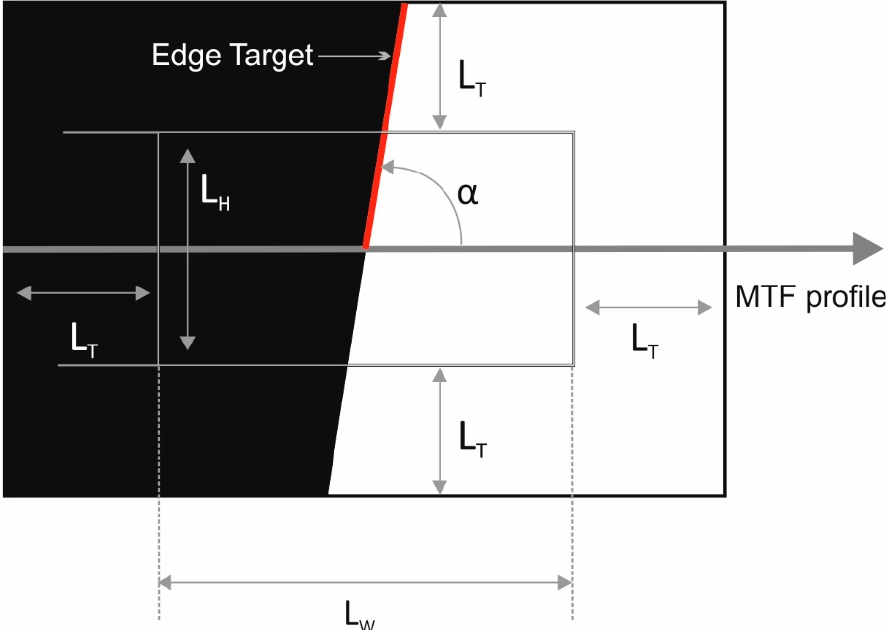
Figure 4. Schematic representation of the parameters for edge target selection (image courtesy [33]). The ESF calculation proposed by Kohm [34] uses the measurements for both orienta- tions (AL and AC). As an example, edge interpolation was performed for every line for the area shown with a red rectangle in Figure 3a. Afterwards, parametric functions were fitted in order to estimte the bottom of the inflection point, and least squares fitting was used to obtain the rotation (Figure 3b). The edge functions (Figure 3c) were finally analyzed, and noisy measurements were